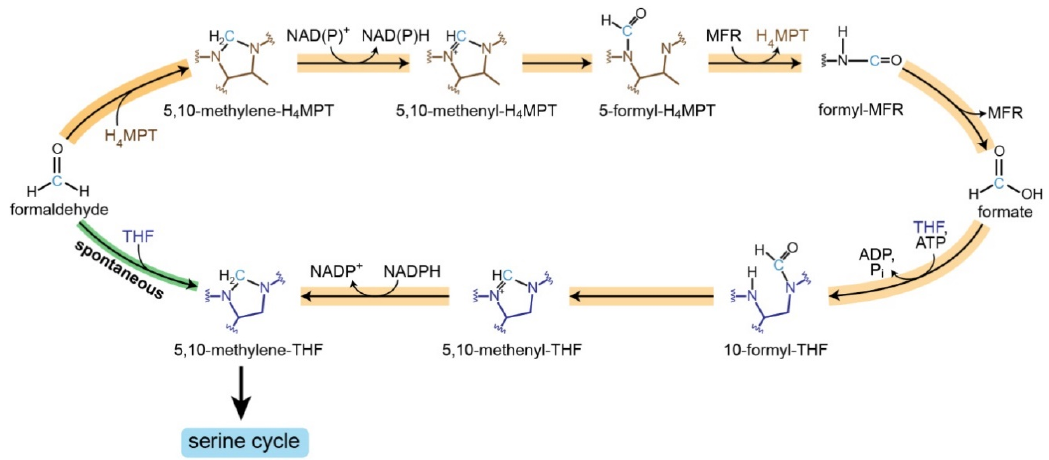
Figure 6. Spontaneous formaldehyde THF condensation bypasses the long and ATP costly tetrahydromethanopterin (H 4 MPT)-dependent